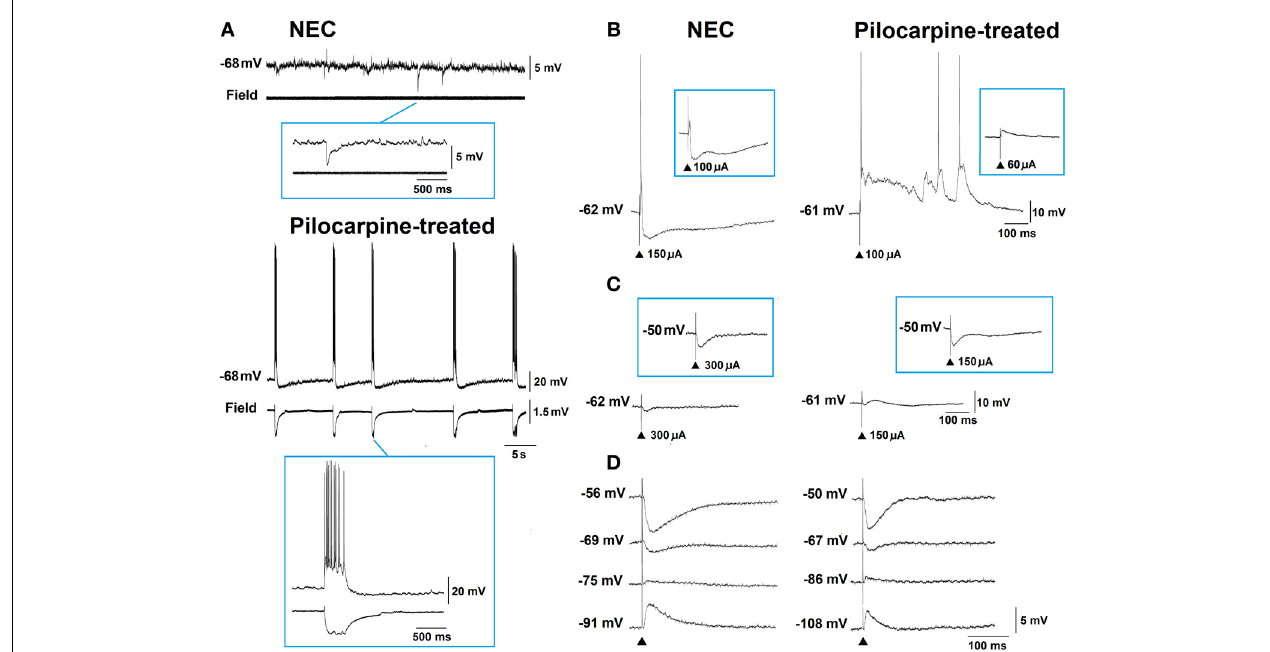
FIGURE 4 | (A) Simultaneous field and intracellular recordings ( − 68mV) in brain slices obtained from non-epileptic control (NEC) and pilocarpine-treated epileptic animals. Note in the NEC recording the presence of depolarizing and hyperpolarizing postsynaptic potentials (PSPs) while robust epileptiform activity occurs in the pilocarpine-treated experiment; expansion of the events is shown in the inserts. (B) and (C) Intracellular responses generated by perirhinal cortex neurons to local single-shock stimulation under control conditions and during blockade of glutamatergic transmission,